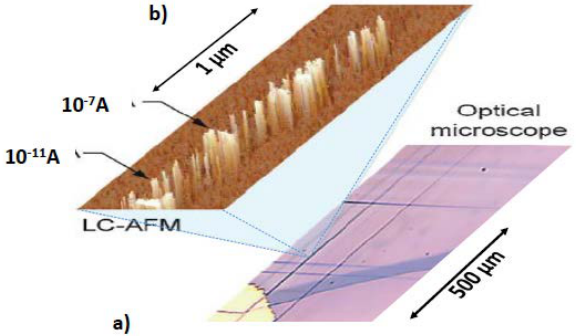
Figure 59. Electroformation of SrTiO 3 single crystals showing an orthogonal structure of filaments induced in the surface layer of SrTiO 3 (100). ( a ) Optical image of the filaments network close to the cathode; ( b ) Conductivity distribution measurement (LCAFM) along the filaments which cross the surface of the SrTiO 3 crystal. Adapted from [45].